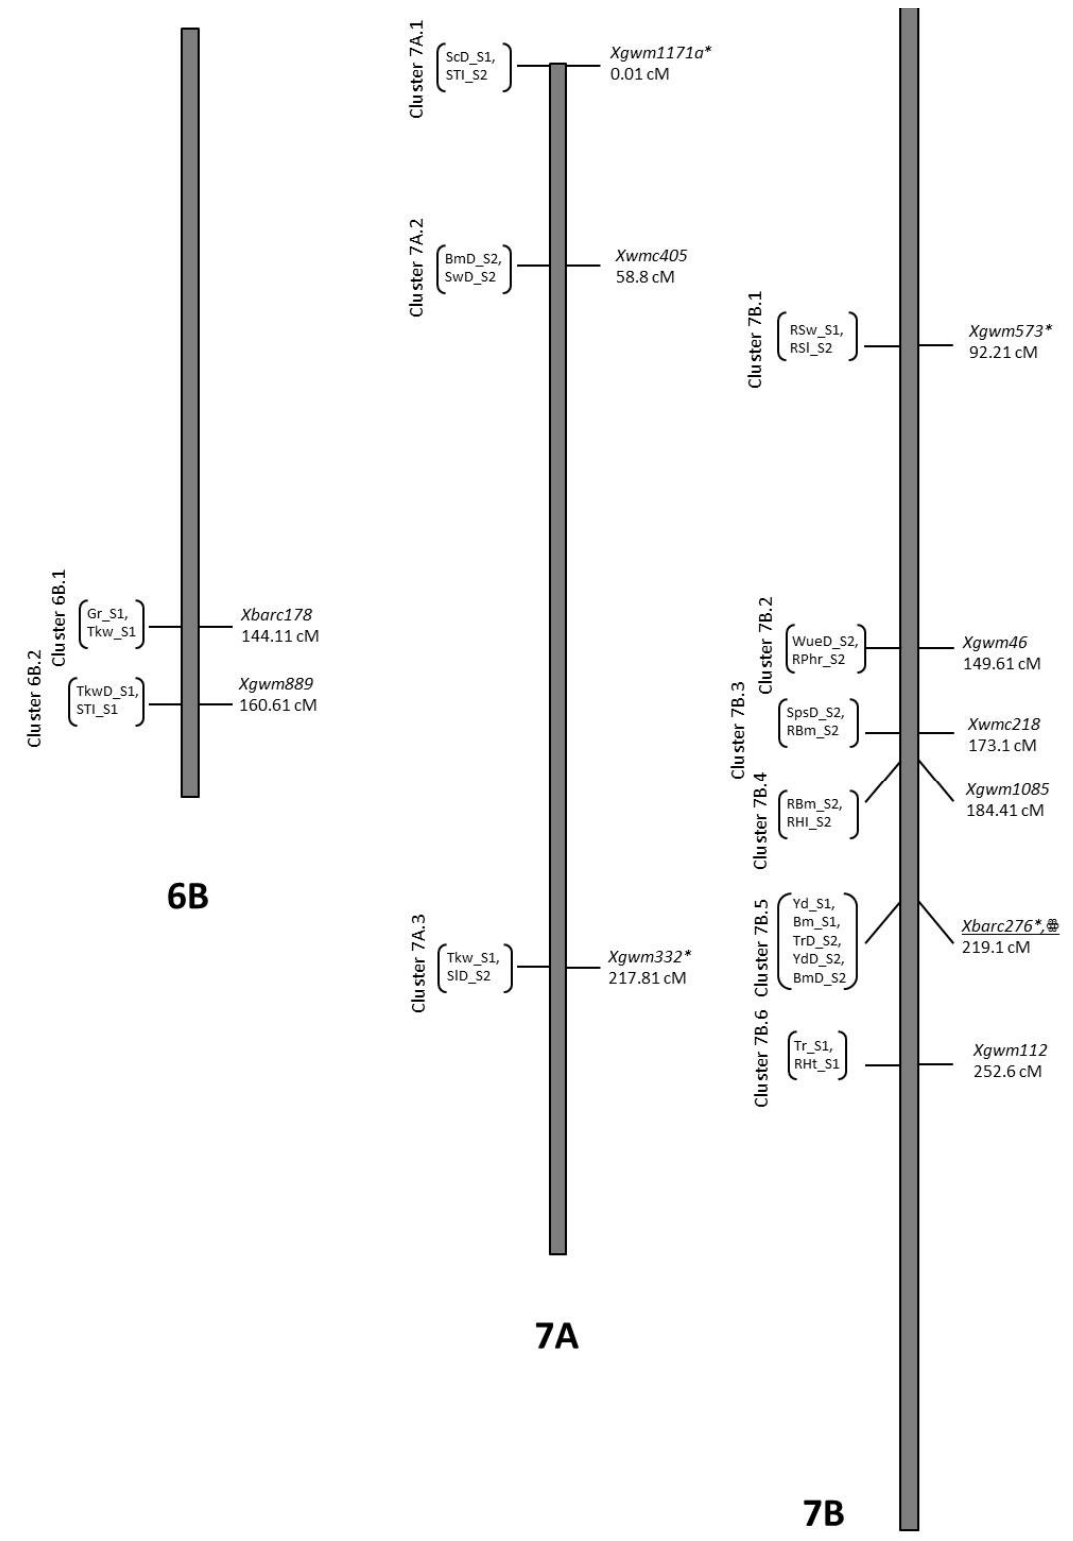
Figure 1. Distribution of QTL clusters in RIL population of durum wheat population. * = marker linked with a QTL in both seasons for any trait, ** = marker linked with the same trait in different conditions in a single season, ꙮ = marker linked with the same trait either in different conditions in both seasons. Markers linked with any yield QTL are under lined. For abbreviation, refer to Table 5.